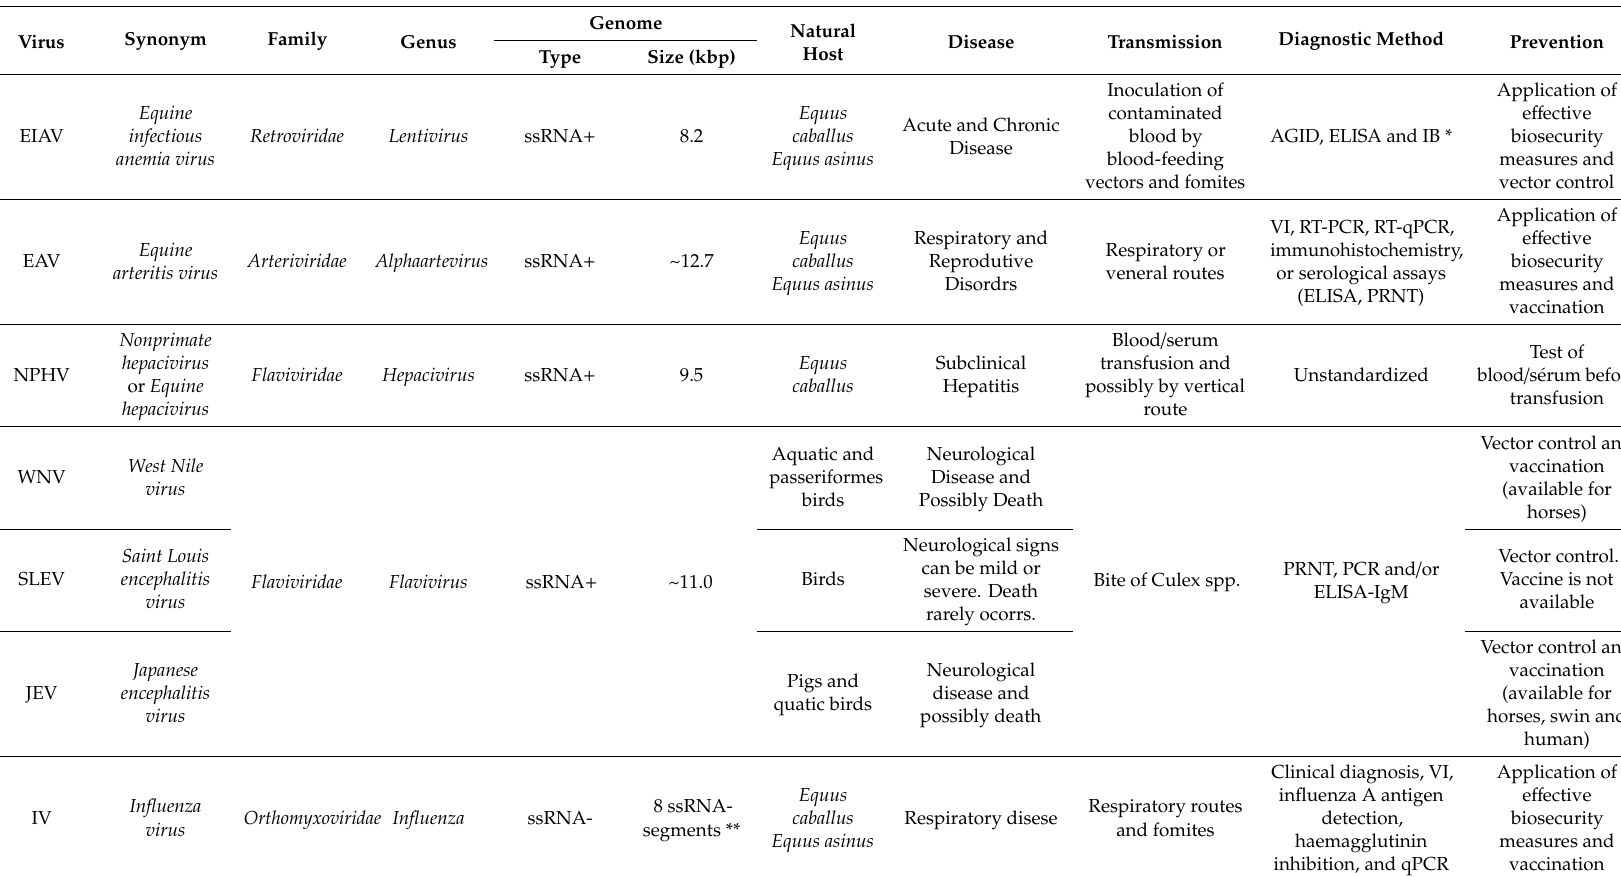
Table 7. Summary of equine viral infectious diseases, listing the infectious agents, their taxonomic grouping, natural hosts, clinical characterization, transmission mechanisms, diagnosis methods and the precautions required to prevent their spread, as determined by World Organisation for Animal Health (OIE) terrestrial